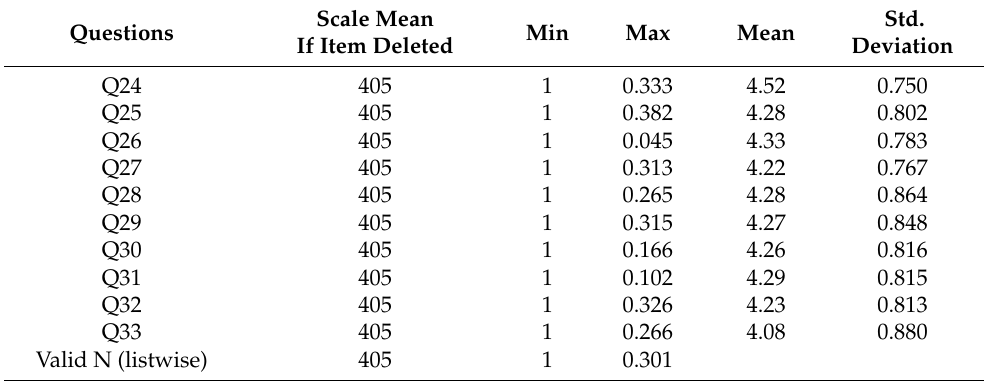
Table 9. Descriptive